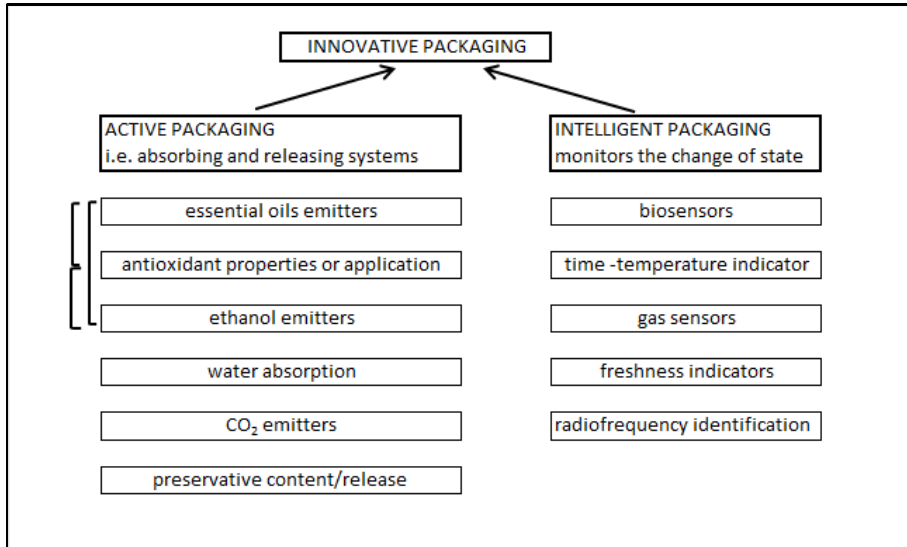
Figure 4. Innovative food packaging systems adapted and modified from [96,101]. Synergies between particular packaging types are marked with